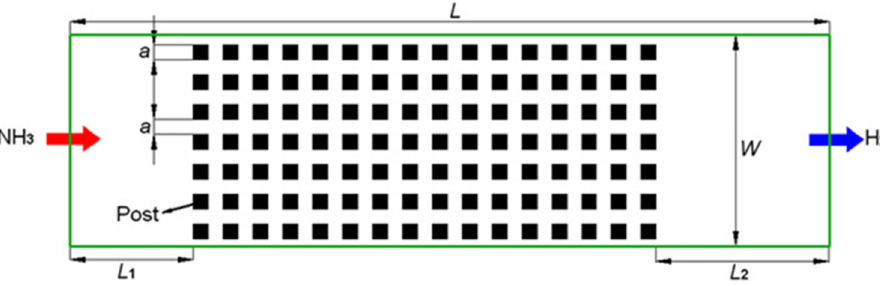
Figure 3. Structures of the post microreactor [20].